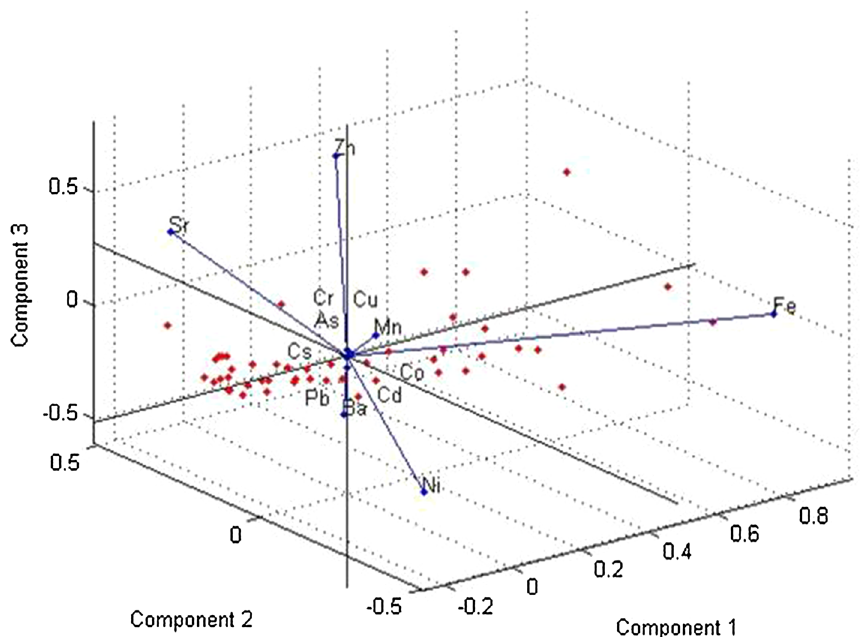
Fig. 2 Principal component analysis of trace metals in